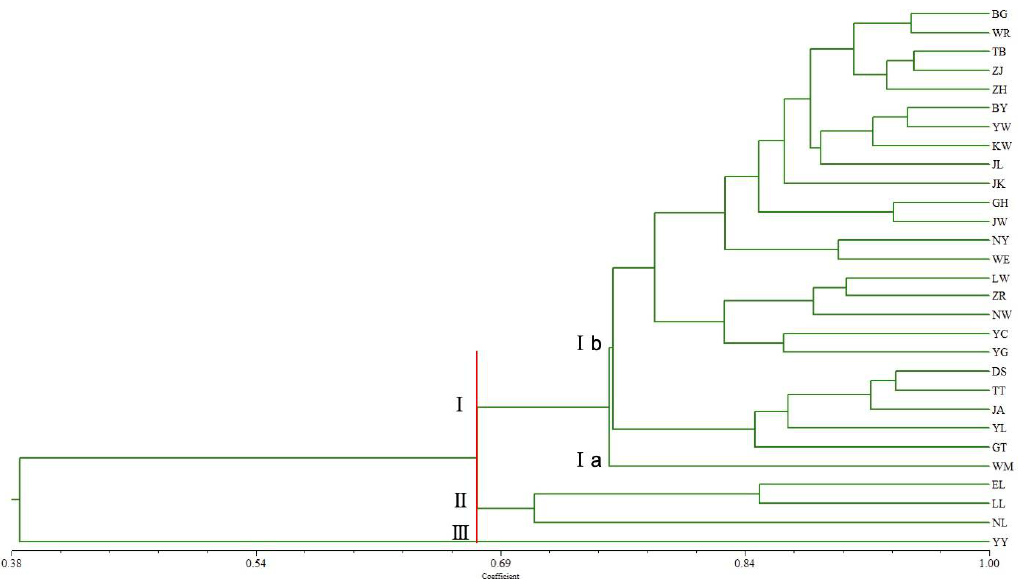
Figure 3. UPGMA dendrogram generated from 10 SSR data showing relationships of twenty-nine Tartary buckwheat populations. (I, II, and III represents three different clusters, and a and b represent a subclass.)